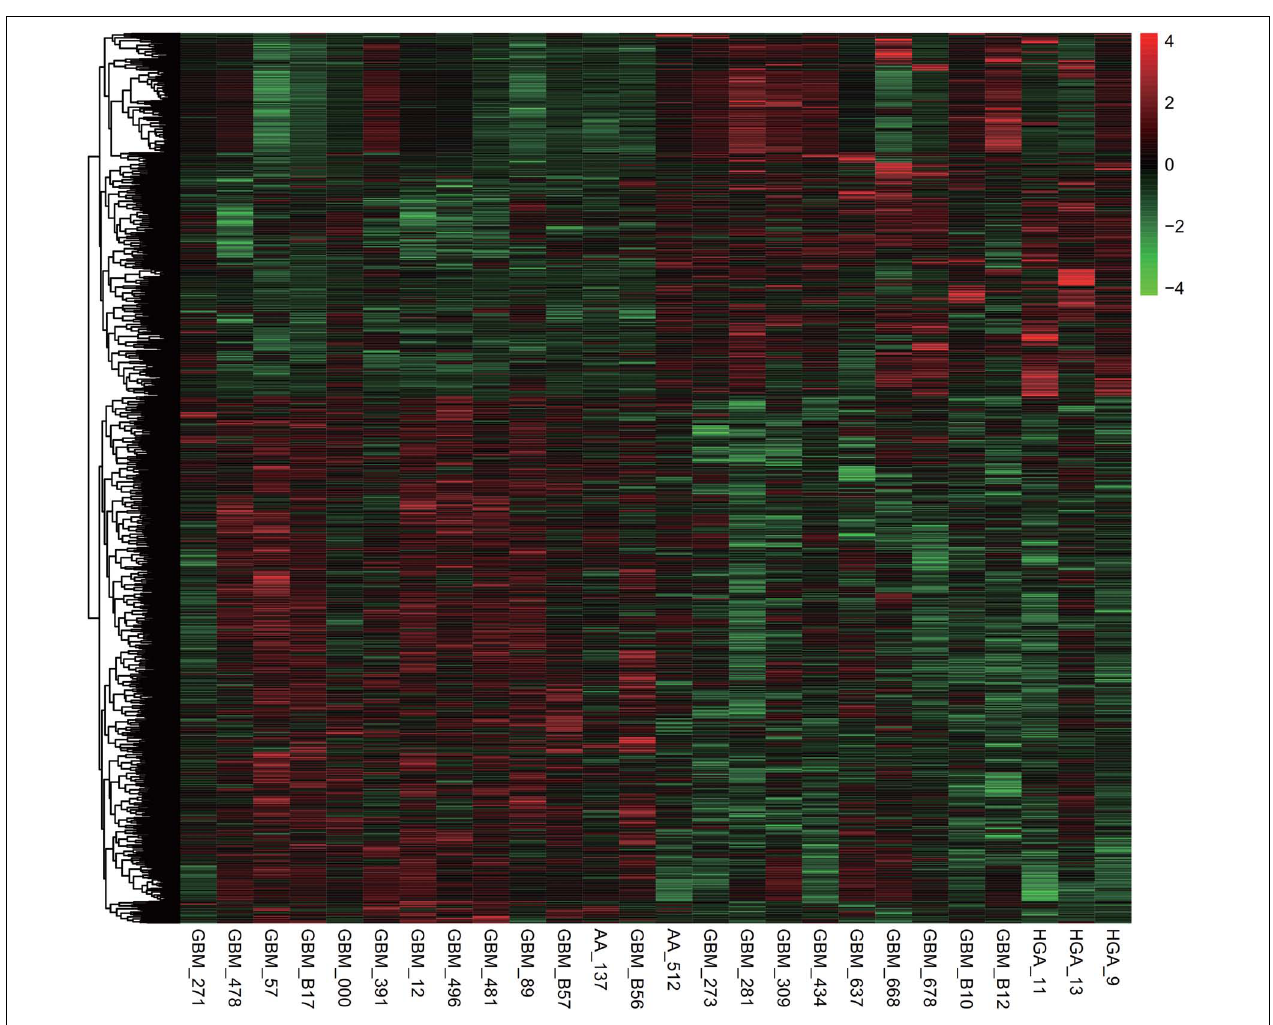
FIGURE 2 | Survival related genes in gliomas were identified using the GSE33331 database of the 955 survival related genes identified in gliomas, 432 genes were related to long survival time, and 523 genes were related to short survival